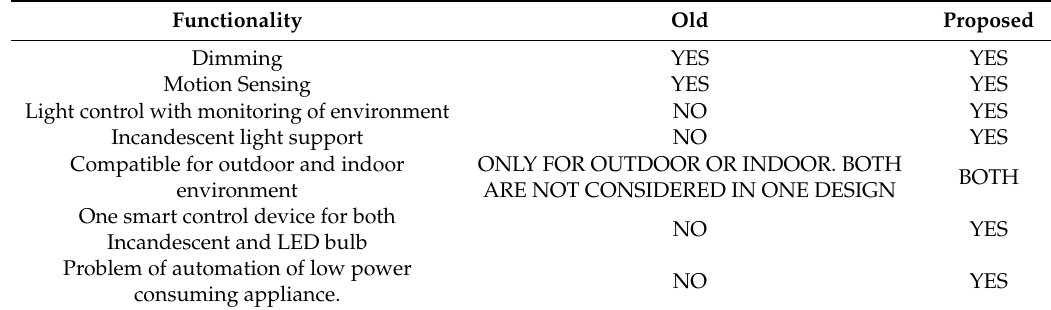
Table 1. Comparison of old devices and the proposed device.